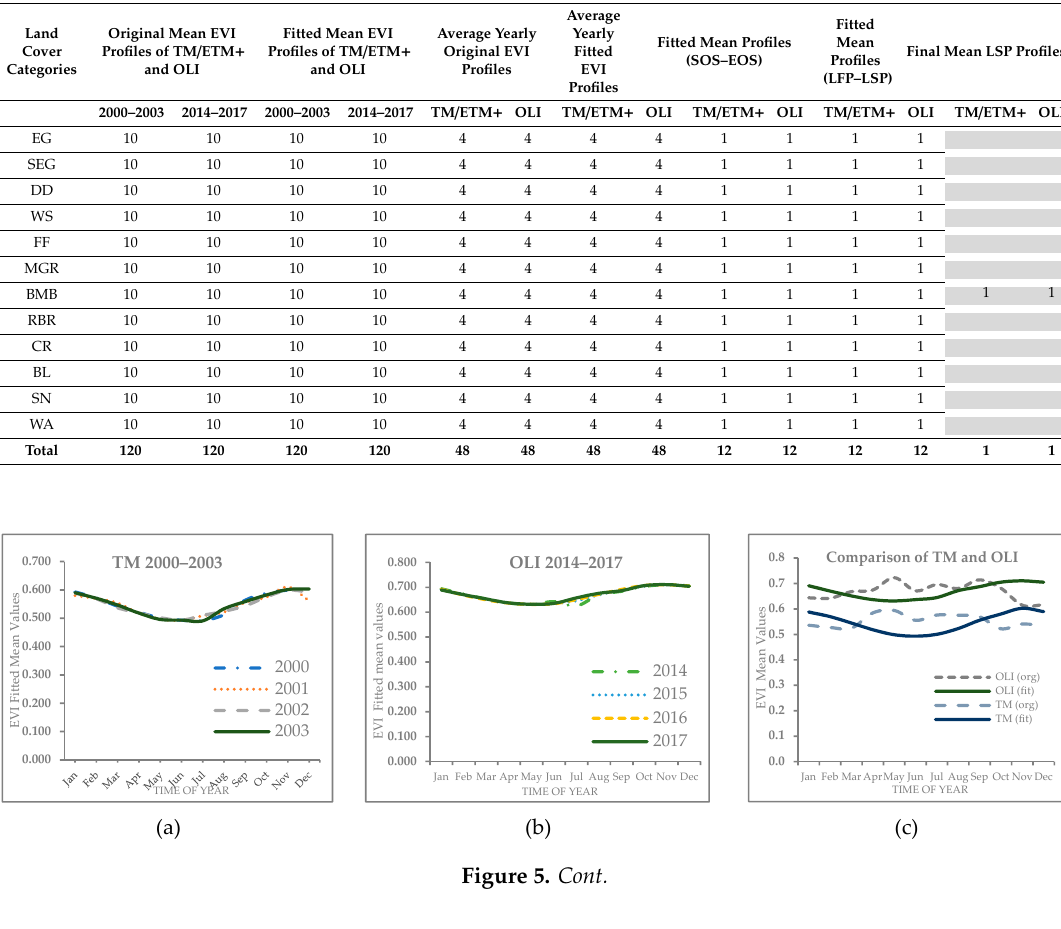
Figure 4. Example of the original and fitted OLI EVI temporal profiles of EG, SEG and DD forests from 2014–2017 generated by the harmonic model. The green dotted lines are the fitted EVI values and the red dotted lines are the original EVI values. The left window shows the GEE algorithms for individual land use categories. The grey image is the composite median OLI EVI image from 2014–2018. The geometry on this image represents the locations of forest categories. Table 2. A number of harmonic EVI profiles were produced to estimate phenology and determine the threshold values for selected land cover categories.